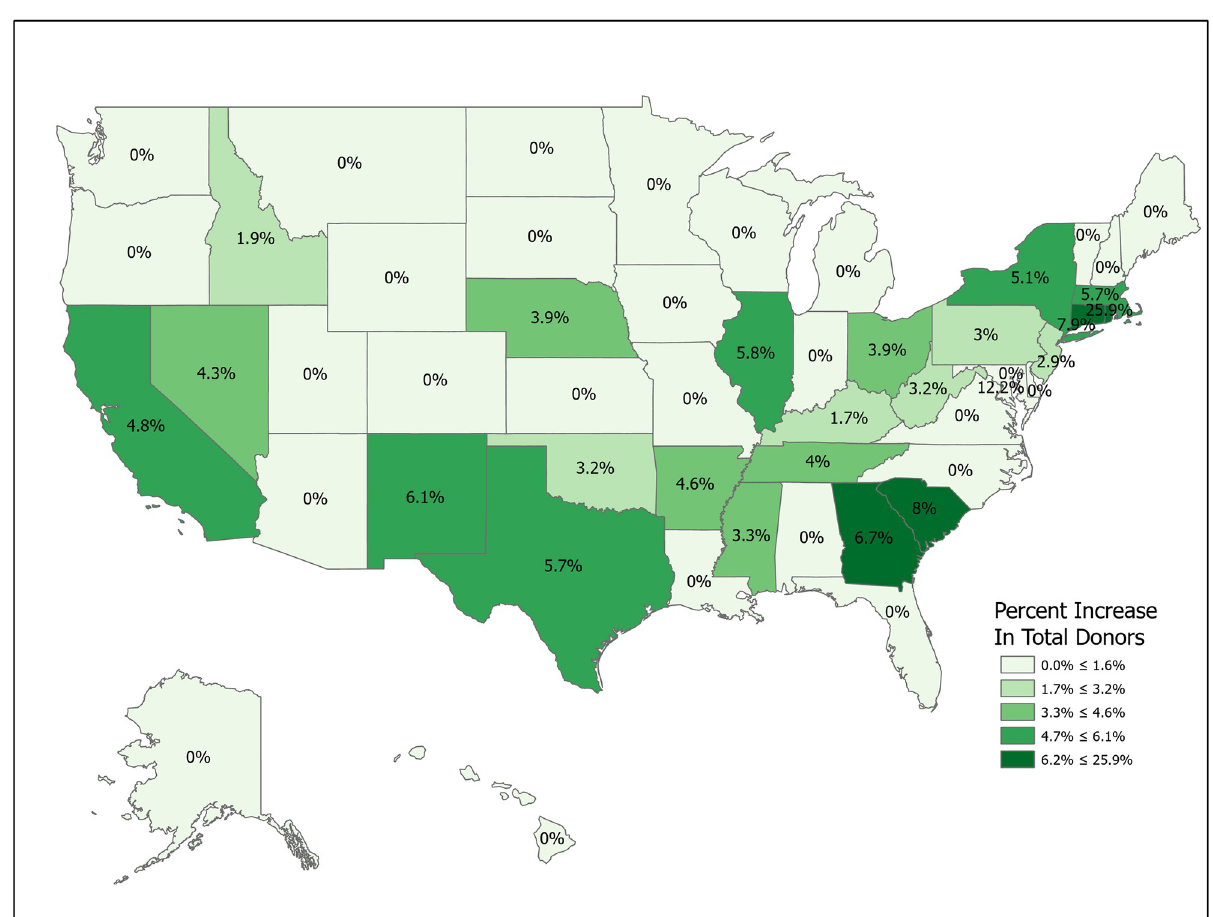
Fig 9. Simulation 3: Target states with low donor registration rates. Data come from Table 6. Maps created by ArcGIS Pro, URL: https://www.esri. com/en-us/arcgis/products/arcgis-pro/overview. Base Map: World Light Gray Base, URL: https://services.arcgisonline.com/arcgis/rest/services/Canvas.